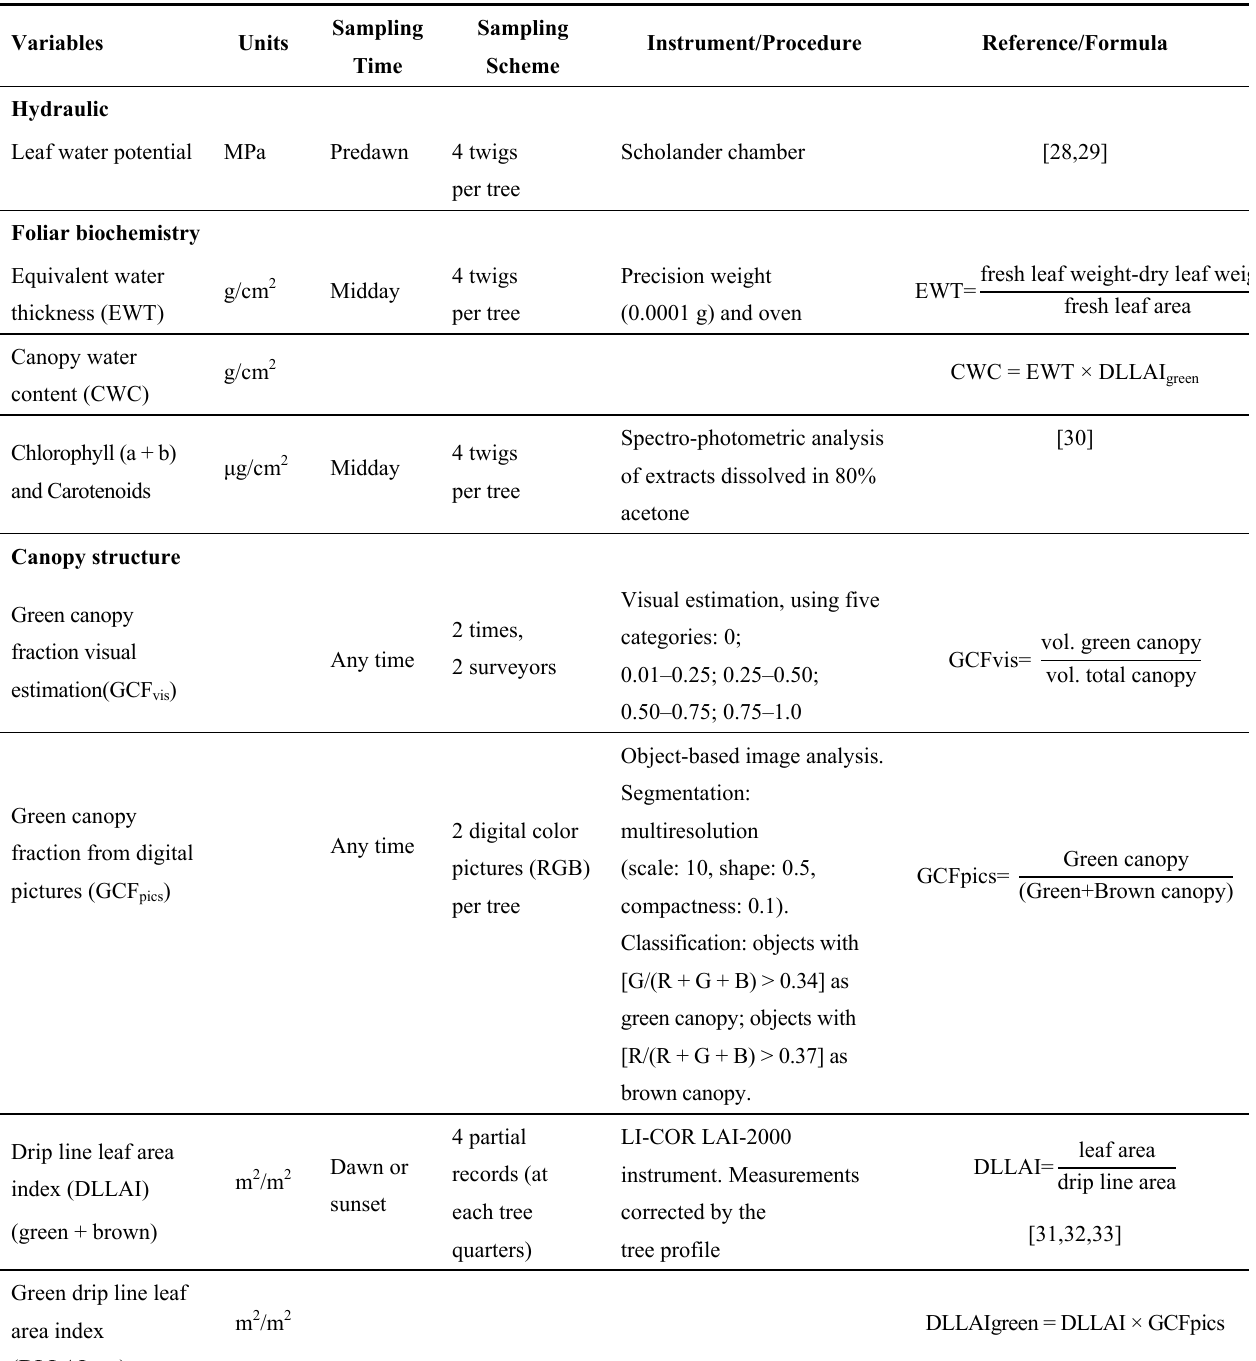
Table 2. Hydraulic, biochemical and structural variables measured for the 32 Tamarugo trees between 24 and 28 January